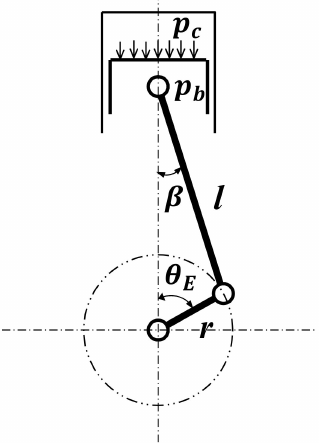
Figure 3. Schematic of single-cylinder